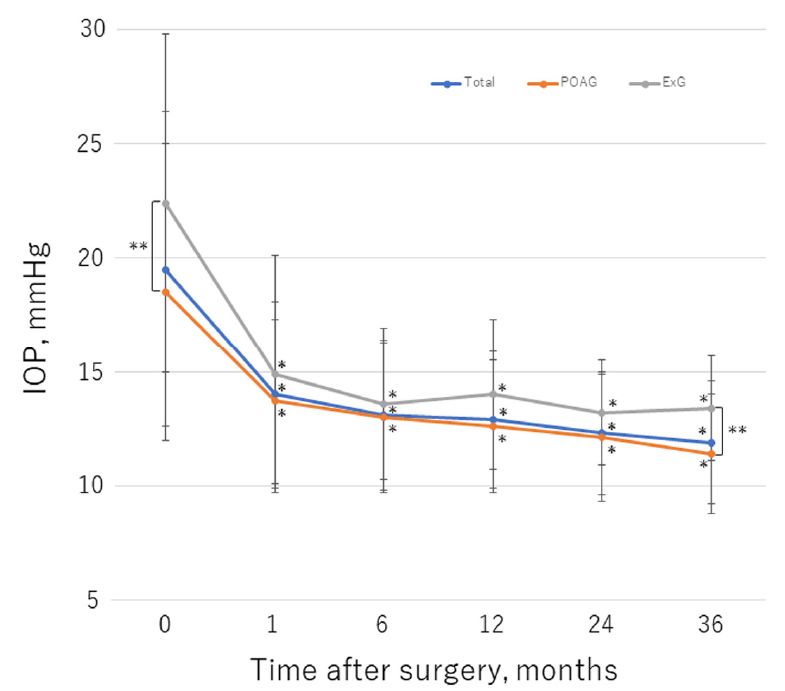
Figure 3. Changes in mean IOP over the course of follow-up. *, statistically significant difference between the preoperative value and each time point. **, statistically significant difference between the POAG and ExG group. Error bar shows the standard deviation. ExG, exfoliation glaucoma; IOP, intraocular pressure; POAG, primary open-angle glaucoma. Table 2. Intraocular pressure and the number of glaucoma medications before surgery and at the postoperative follow-up visits.